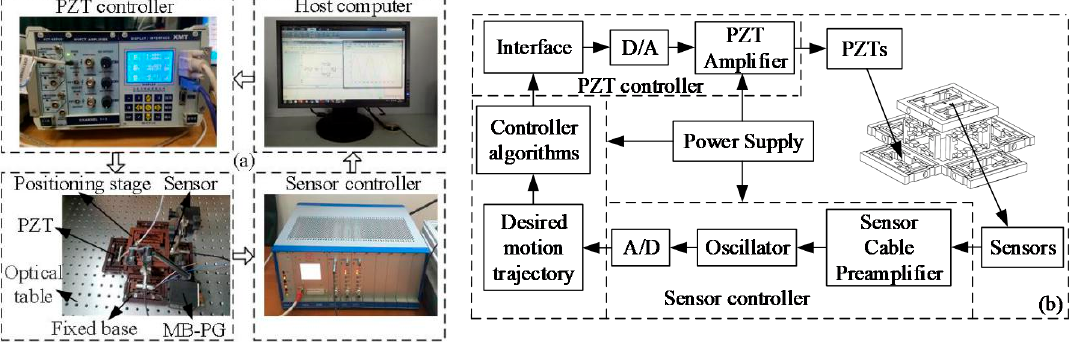
Figure 5. Schematic diagram of the 6-DOF micro-positioner: ( a ) experimental setup, ( b ) hardware connection.